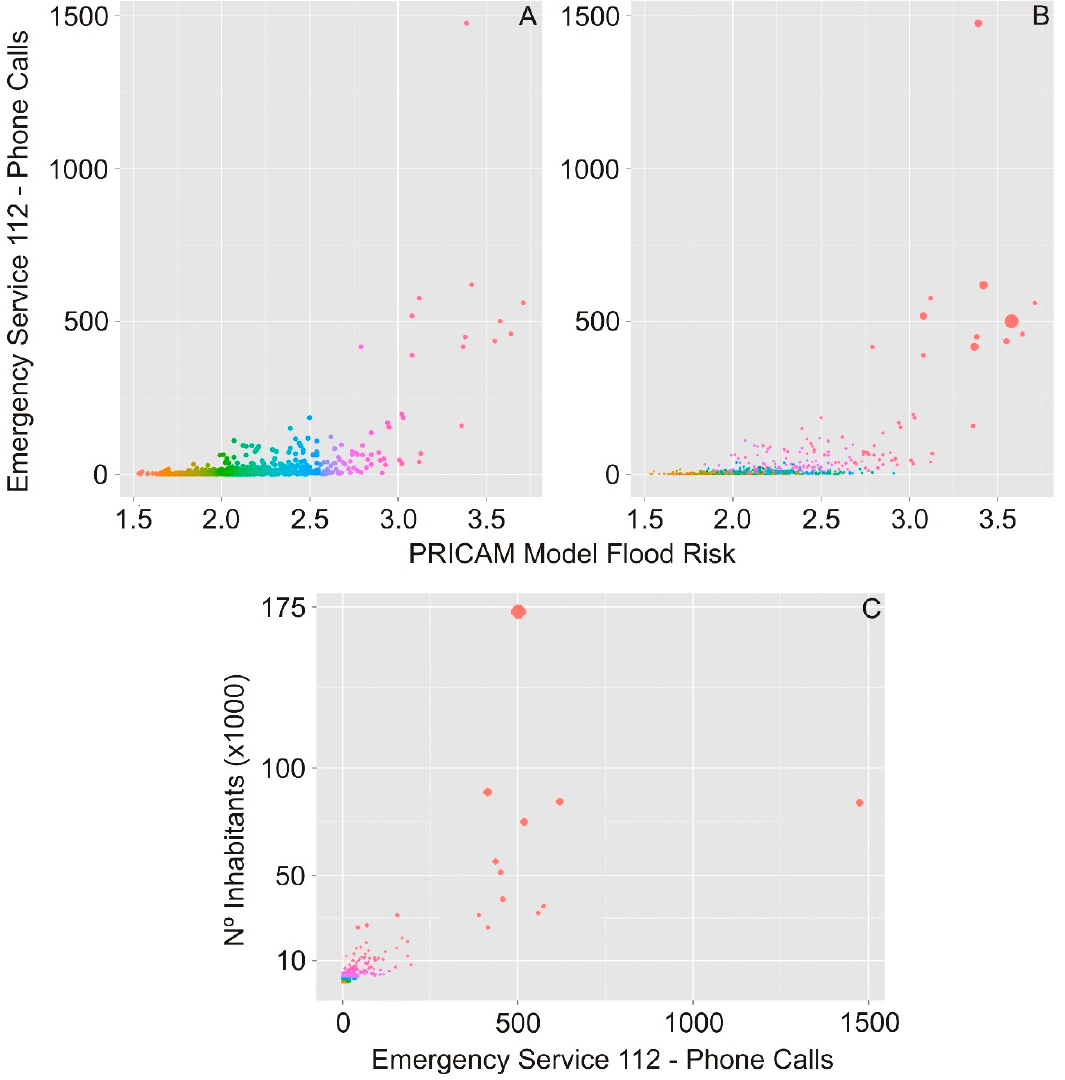
Figure 5. Emergency Service 112 (phone calls) vs. PRICAM model flood risk values ( A ), with color dots size ( B ) showing urban centers population size. N° of Inhabitants vs. Emergency Service 112 phone calls ( C ), with color dots size showing urban centers population size.